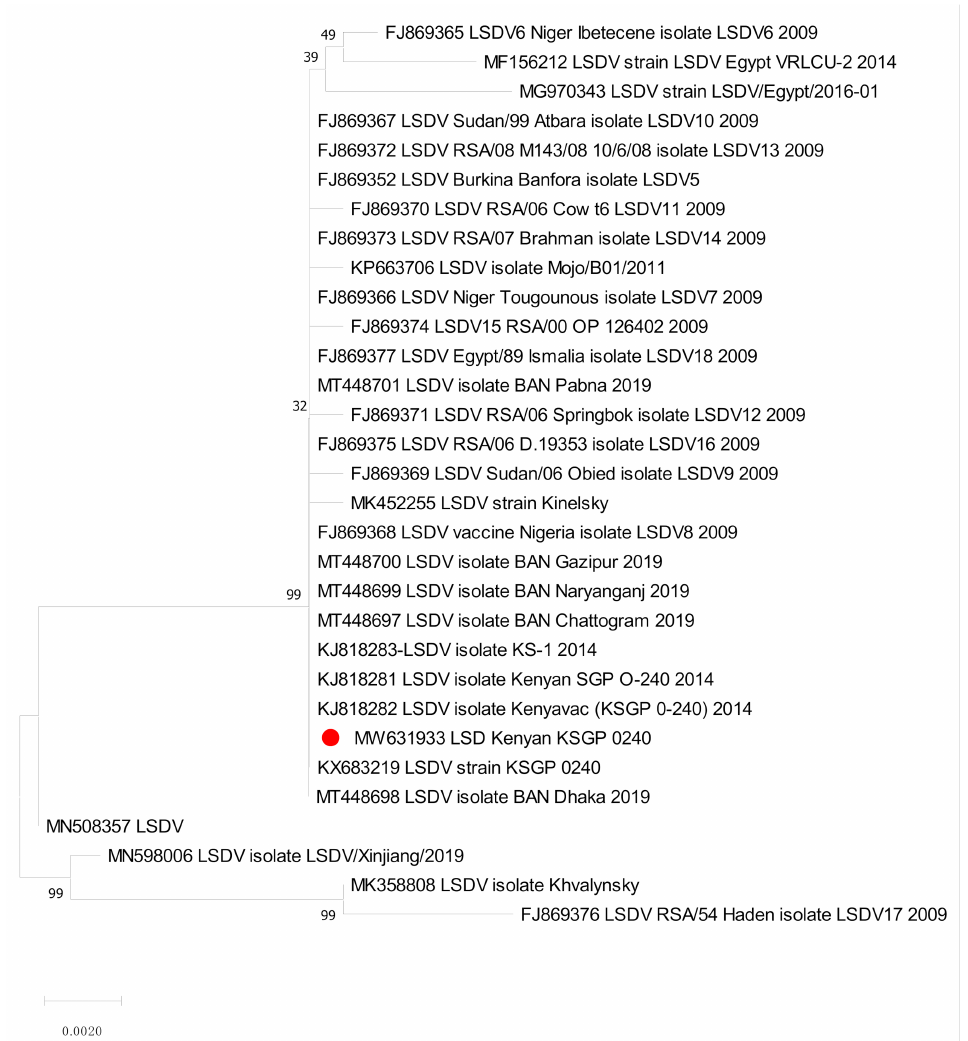
Figure 2. Molecular phylogenetic analysis of KSGP O-240 strain based on the Capripoxvirus G-protein- coupled chemokine receptor (GPCR) gene. The GPCR sequence obtained in this study was marked with red circle shaped